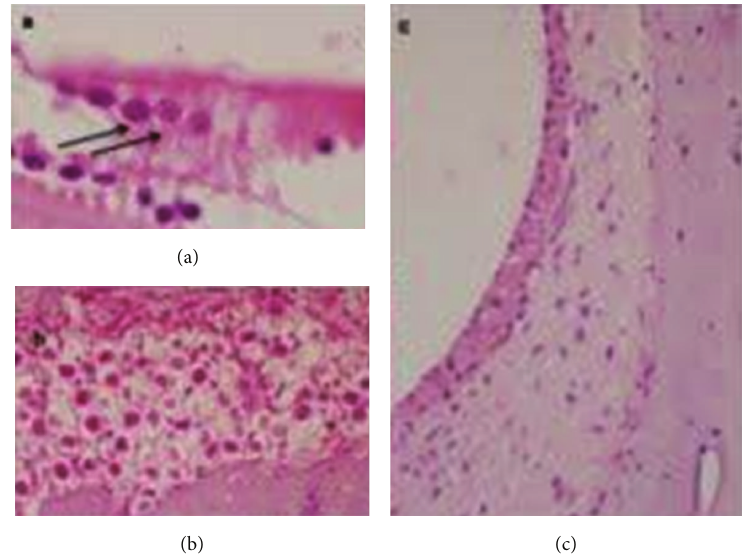
Figure 1: Normal microarchitecture of the organ of Corti, and ( ↑↑ ) OHCs can be seen (Figure 1(a), H&E; × 1000), spiral ganglion neurons (Figure 1(b), H&E; × 400), and stria vascularis without changes (Figure 1(c), H&E; × 400).